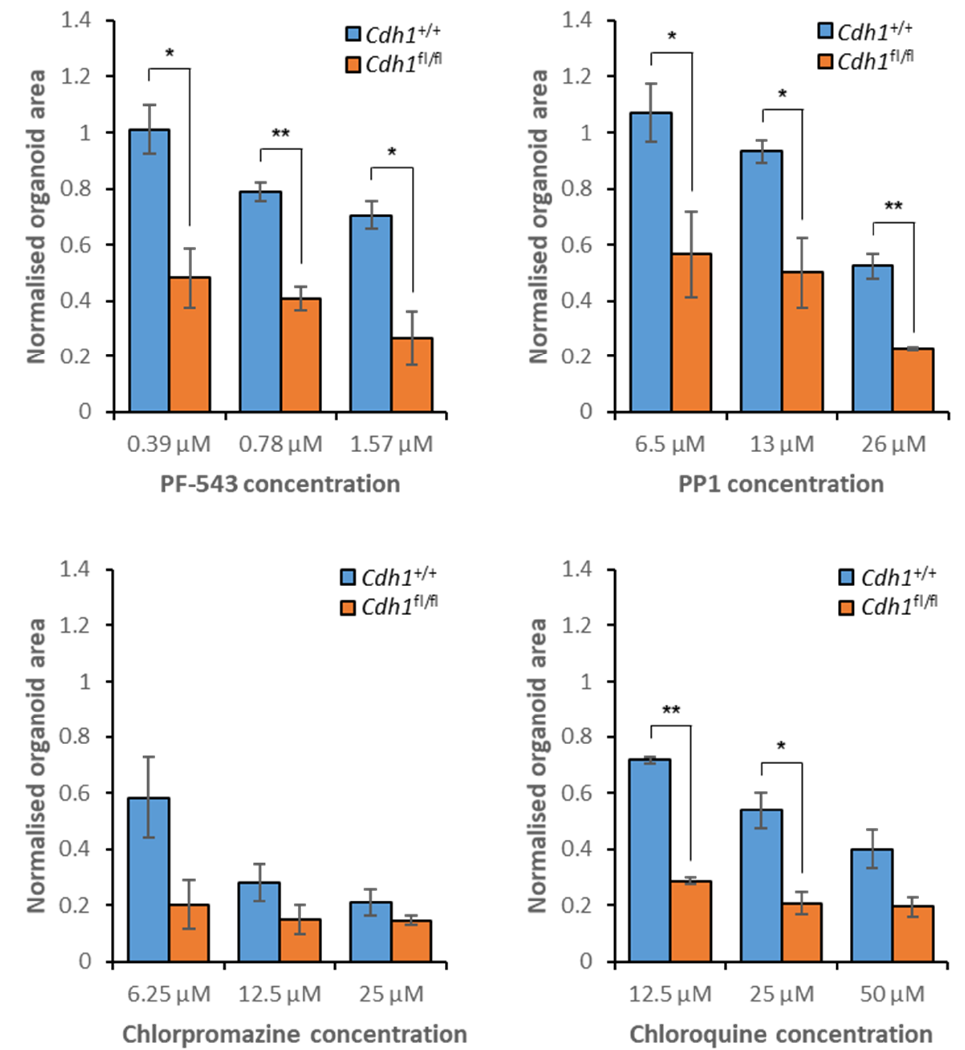
Figure 9. Sensitivity of gastric organoids to treatment with candidate synthetic lethal compounds. Both Cdh1 +/+ and Cdh1 fl/fl organoids were drugged, then viability was quantified through measure- ment of organoid area, normalized to vehicle controls. Average values were calculated from three biological replicates, with +/- 1 standard error of the mean depicted by error bars. P- values were calculated using Student’s t- test; * p ≤ 0.05, ** p ≤ 0.01.